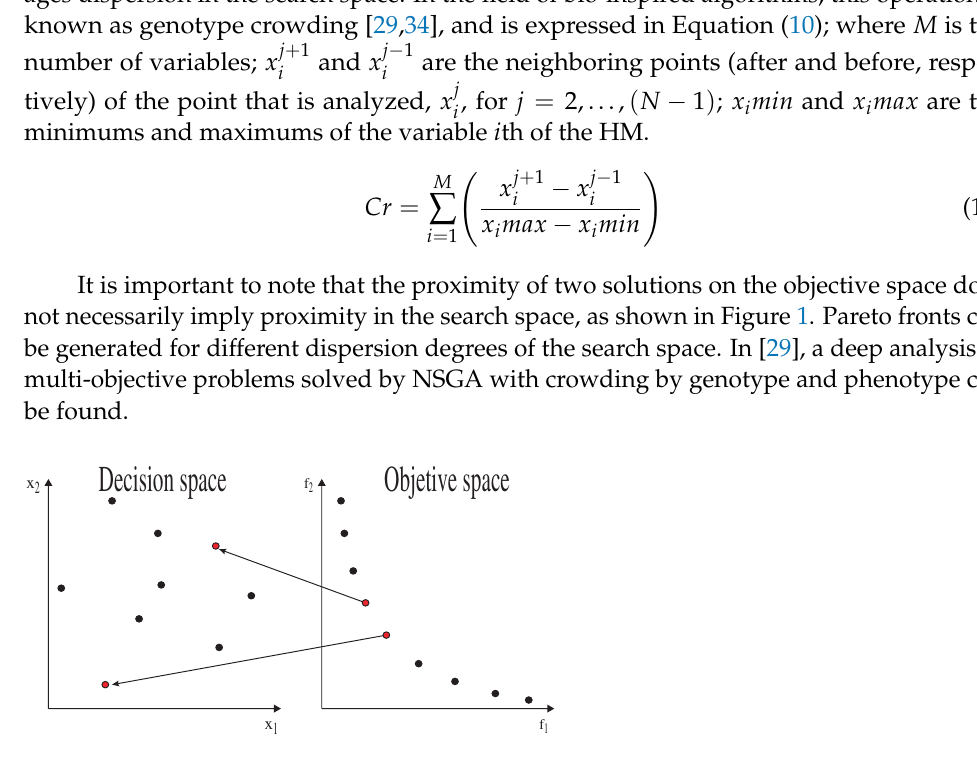
Figure 1. An example with two neighboring solutions in the front that are distant from each other in the search